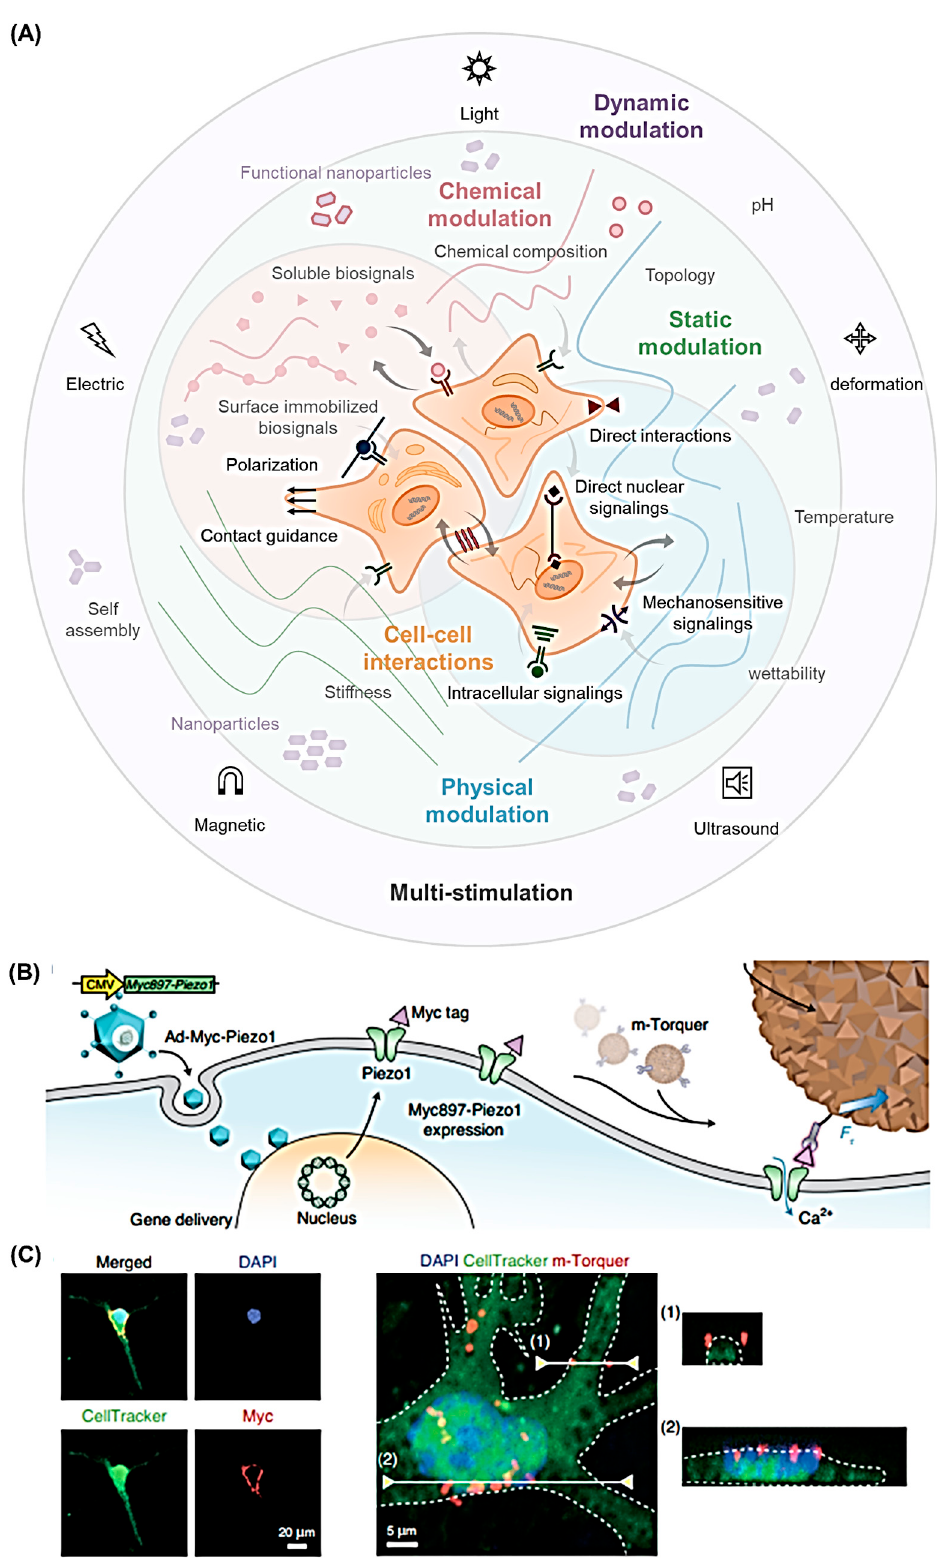
Figure 3. Complex interactions during cellular behavior modulation. ( A ) The physical and chemical properties of the ECM determine cell fates through a variety of mechanisms, such as direct interaction, intracellular signaling, direct nuclear signaling, and mechano-sensitivity signaling. ( B ) Example of dynamic modulation using magnetic stimuli. Schematic of genetic encoding of Piezo1 by Ad-